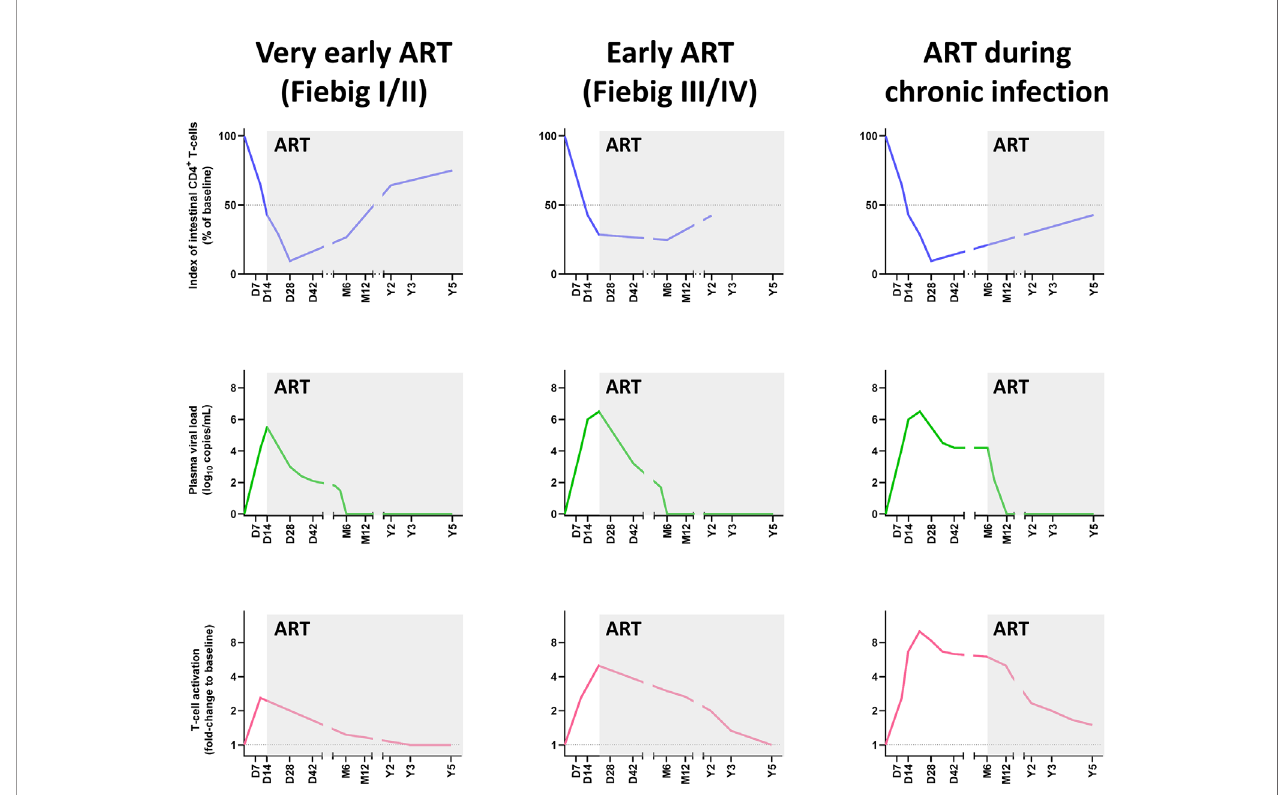
FIGURE 3 | Comparative dynamics of intestinal CD4 + T-cell depletion, plasma viral load and immune activation/in fl ammation in treated HIV infections, according to the timing of initiation of antiretroviral therapy ART. Schematic representation of intestinal CD4 + T-cell depletion, viral replication and immune activation is inferred from data reported in references (85, 90, 91, 99, 219 – 221). Longitudinal data are presented, with the X axis representing days (D), months (M) and years (Y) postinfection. The Y axis illustrates the magnitude of mucosal CD4 + T-cell depletion (upper panels), viral replication (middle panels), and the levels of immune activation/in fl ammation (lower panels). Intestinal CD4 + T-cell depletion is illustrated as the index of CD4 + T cells (i.e., percentage of CD4 + T cell fraction within the CD3 + T cell population, divided by this percentage at baseline). Viral replication is represented as plasma viral loads. From the plethora of biomarkers of immune activation/in fl ammation, we selected the fold-change of HLA-DR + CD38 + CD8 + T cells in persons living with HIV, compared to uninfected individuals. ART, Antiretroviral